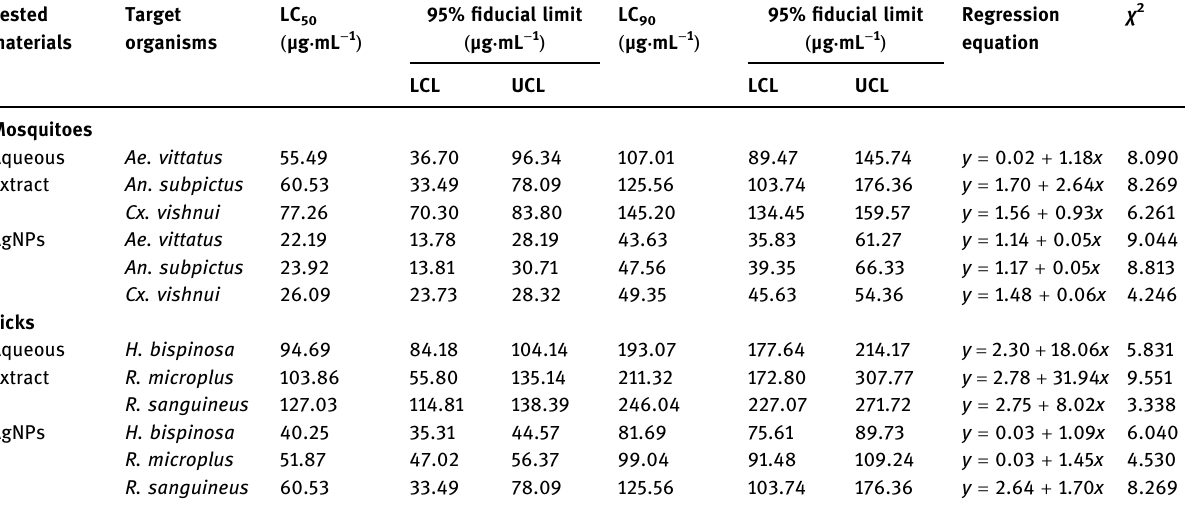
Table 1: Larvicidal activity of A. monophylla ALE and synthesized AgNPs against mosquitoes and ticks Tested